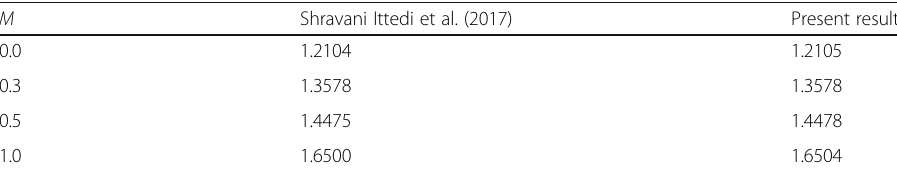
Table 1 Comparison of skin friction coefficient − f ′ ′ (0) for different values of magnetic field parameter M when E = 0, β = 0, Le = 2.0, Pr = 2.0, and h = 0.1 M Shravani Ittedi et al. (2017) Present result 0.0 1.2104 1.2105 0.3 1.3578 1.3578 0.5 1.4475 1.4478 1.0 1.6500